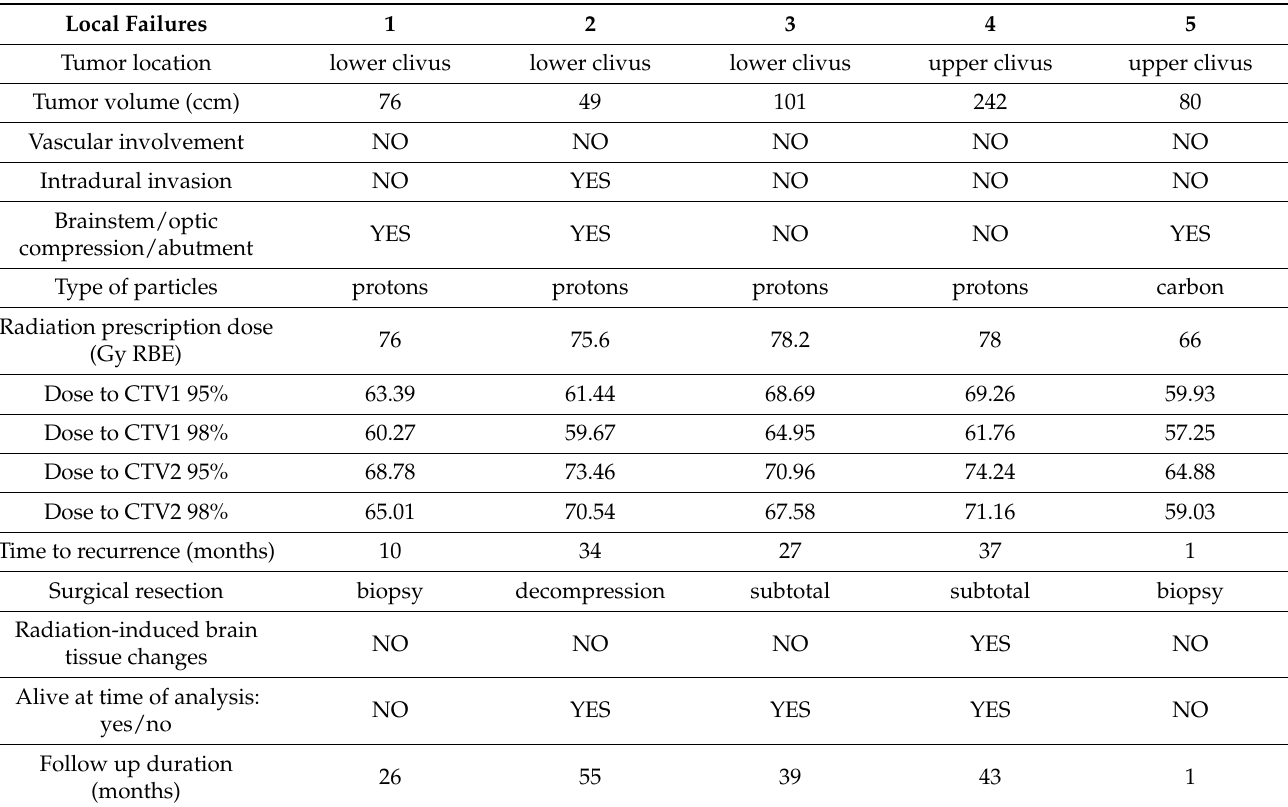
Table 2. Characteristics of five patients who experienced local failure following the particle therapy by MedAustron.